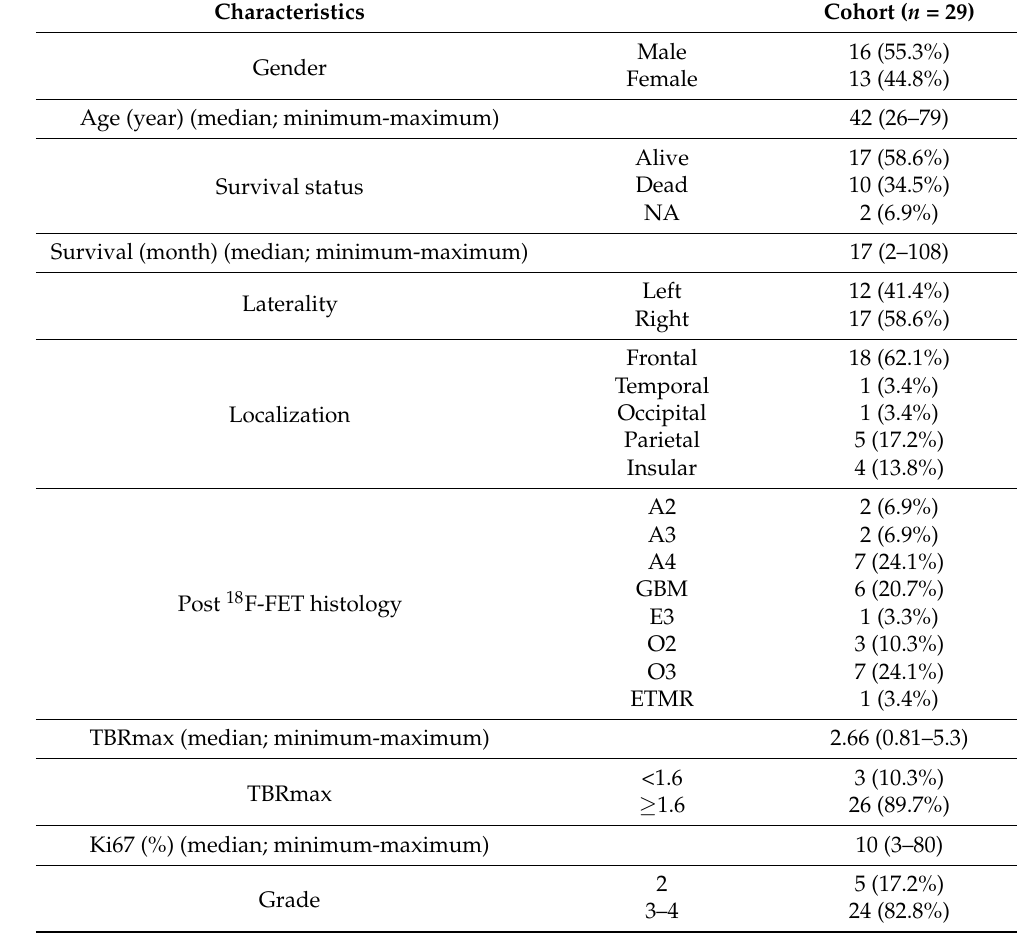
Table 1. Characteristic of the studied brain tumor